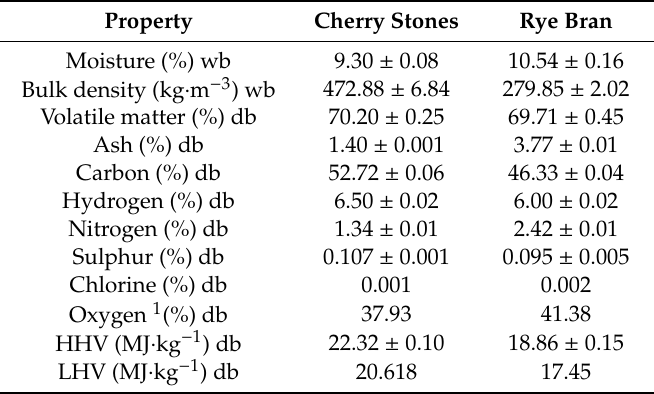
Table 1. Properties of cherry stones and rye